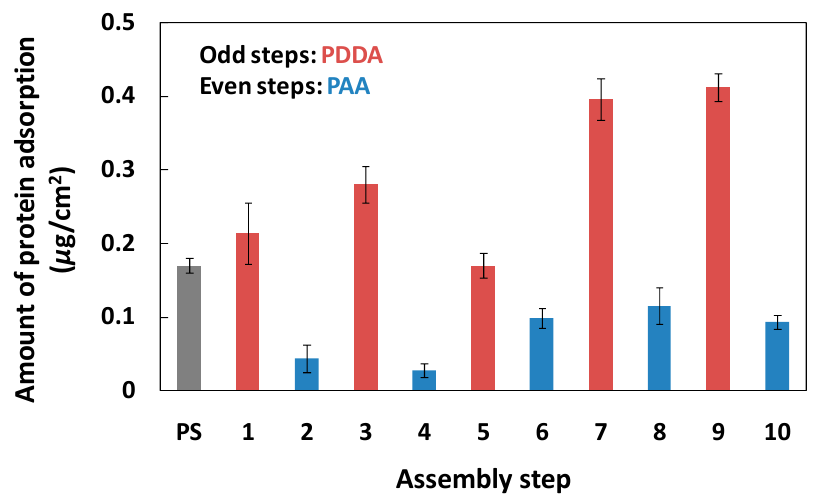
Figure 1. Amount of primary antibody adsorption on the PS plate and the PDDA/PAA PEMs. The odd and even steps represent the PDDA layers and PAA layers, respectively ( n = 3).